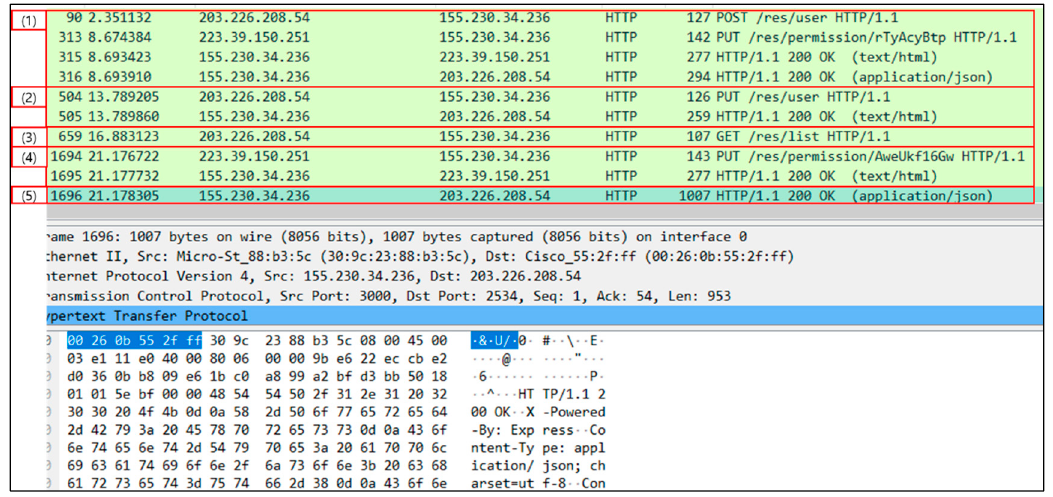
Figure 16. Packet capturing results for resource list request by user.